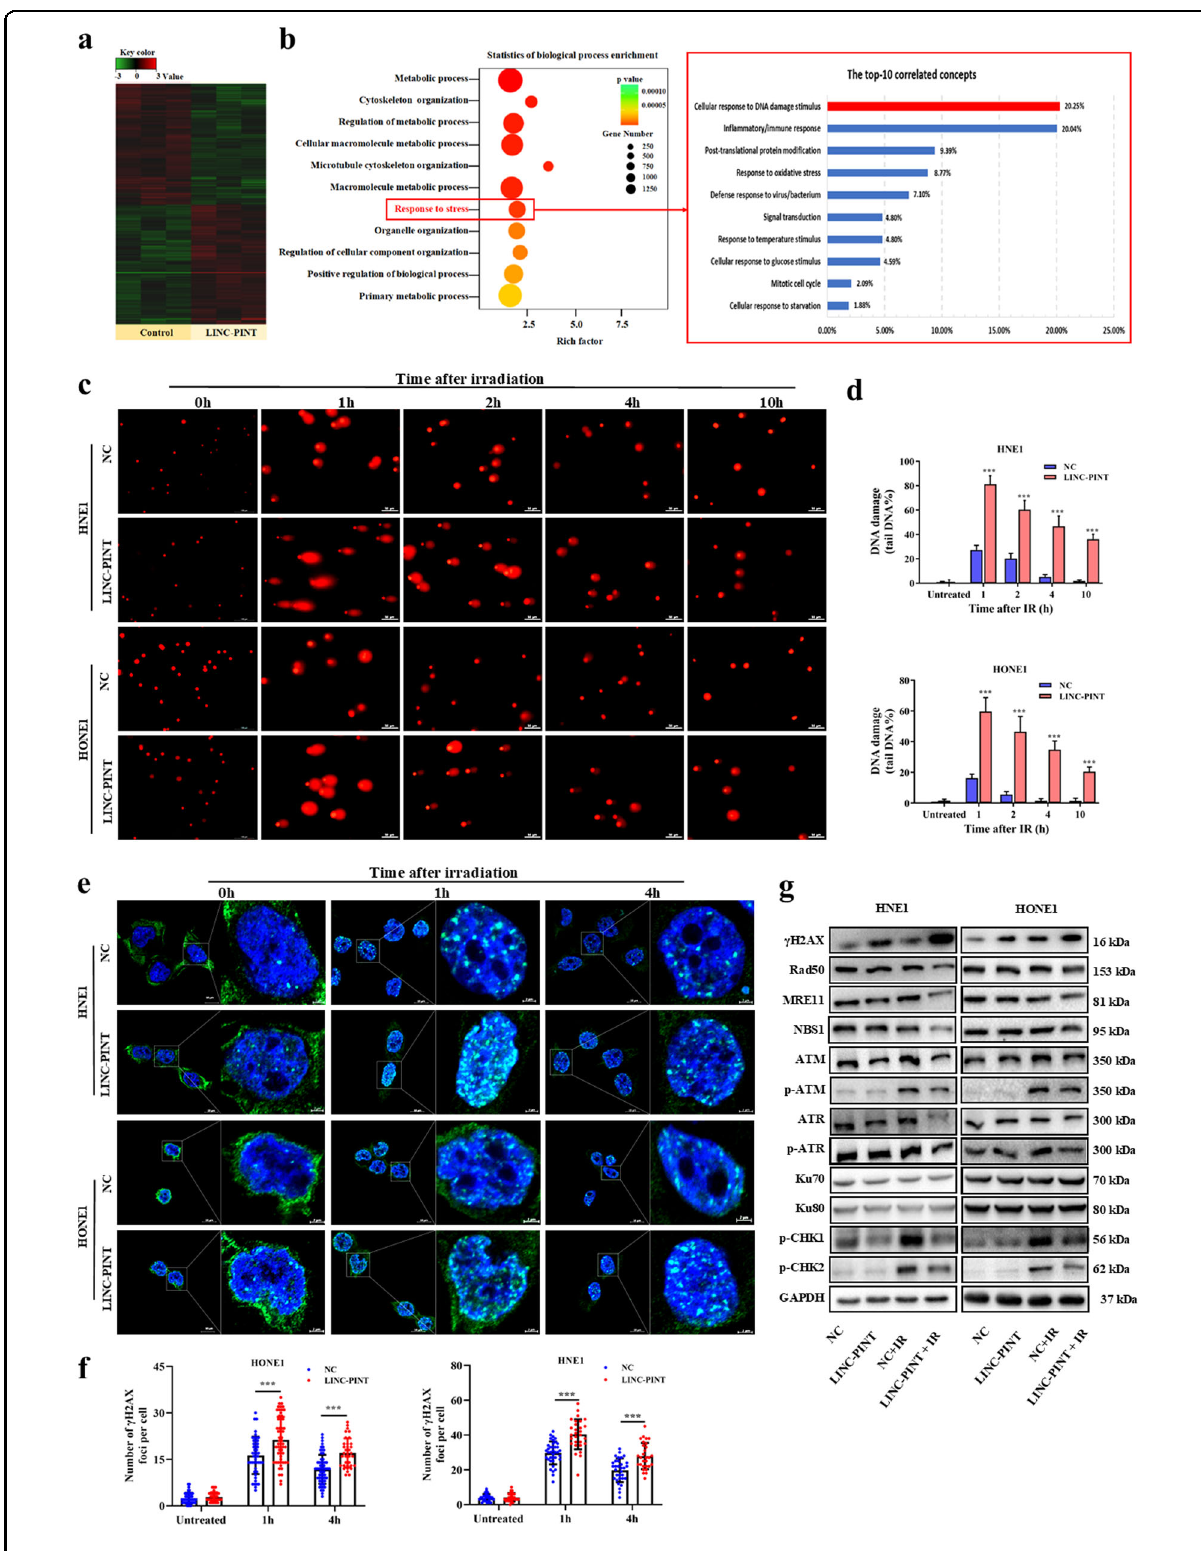
Fig. 4 (See legend on next